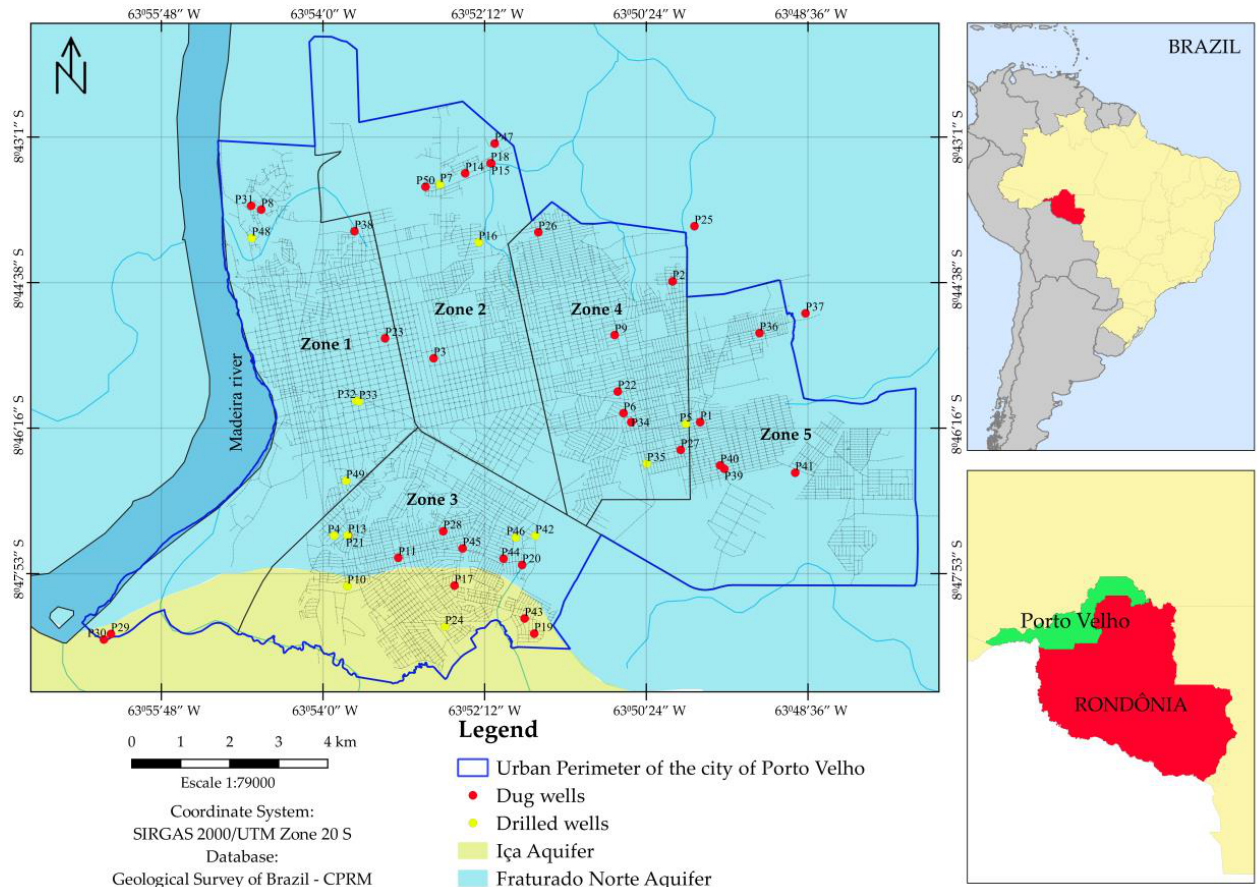
Figure 1. Urban area of the city of Porto Velho, showing the wells sampled.